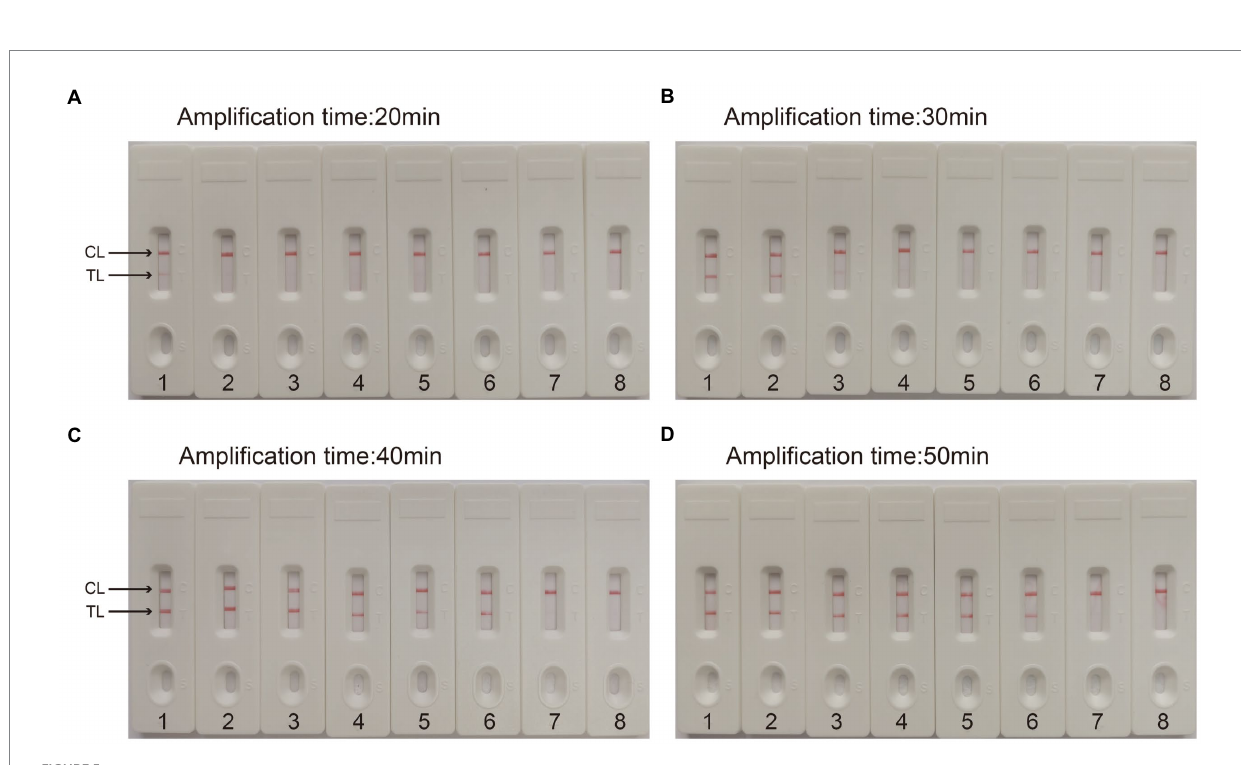
FIGURE 5 Optimal detection time required for CVA16-MCDA-LFB assay. Four different reaction times [ (A) 20 min; (B) 30 min; (C) 40 min; (D) 50 min] were evaluated at 64 ° C. Biosensors 1–7 represent pUC57-CVA16-VP1 DNA levels of 4 × 10 6 to 4 × 10 0 copies per reaction, respectively; 8 represents a blank control double-distilled